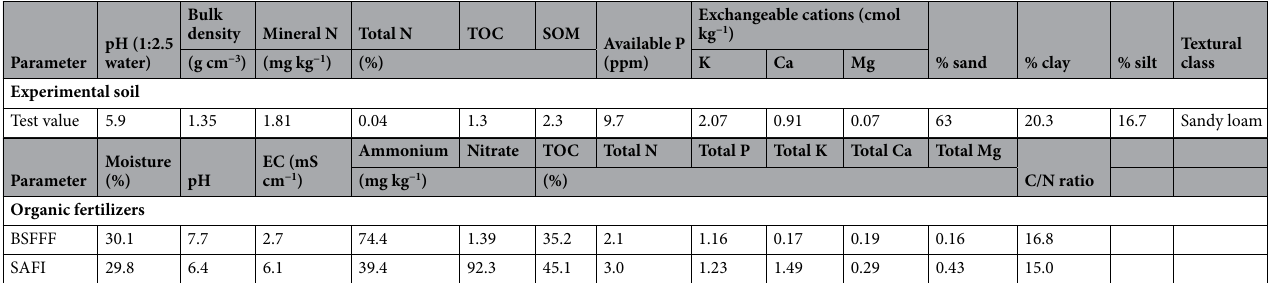
Table 5. Selected physical and chemical characteristics of the experimental soil, and organic fertilizers. TOC total organic carbon, SOM soil organic matter, BSFFF black soldier fly frass fertilizer, SAFI commercial organic fertilizer, n =